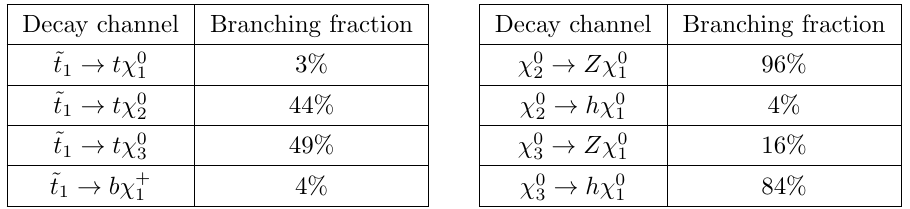
and (cid:31) 0 for the benchmark point listed in table 1. 2 3